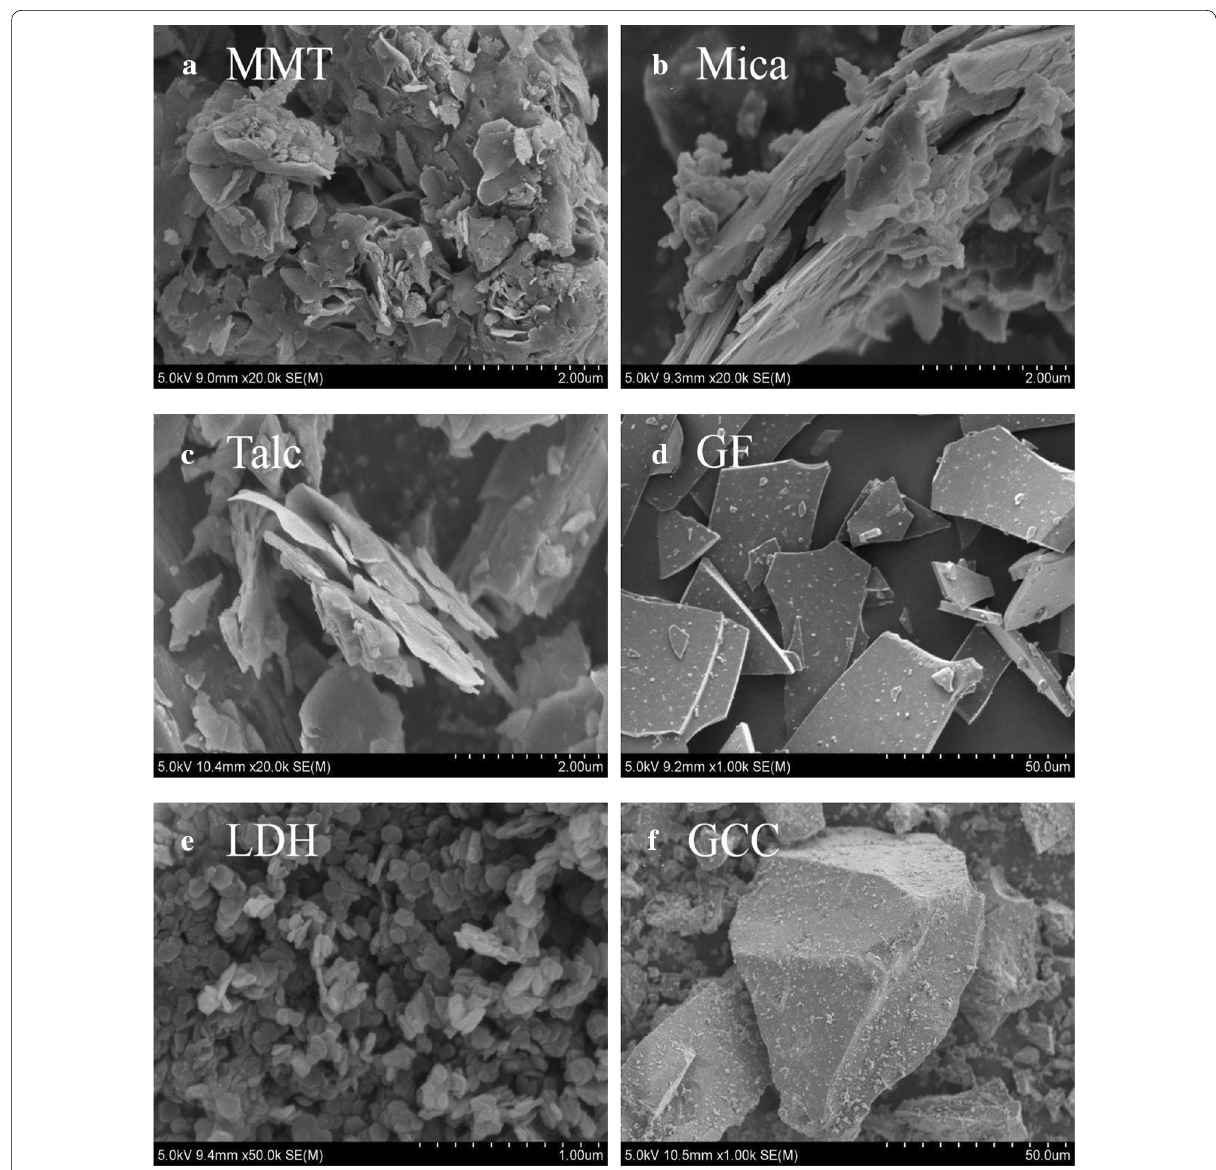
Fig. 6 The SEM micrographs of fillers a MMT; b mica; c talc; d GF; e LDH; f